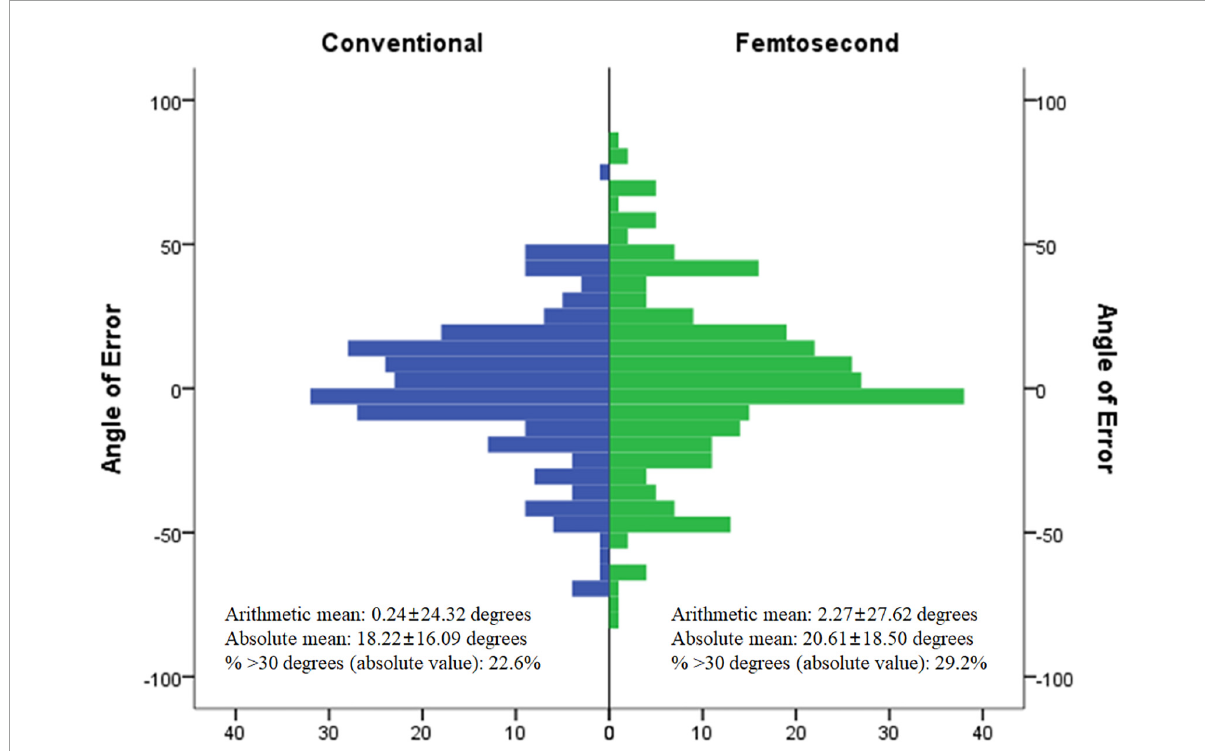
FIGURE1 Angle of error between conventional group and femtosecond group in target induced astigmatism over 0.75 D.